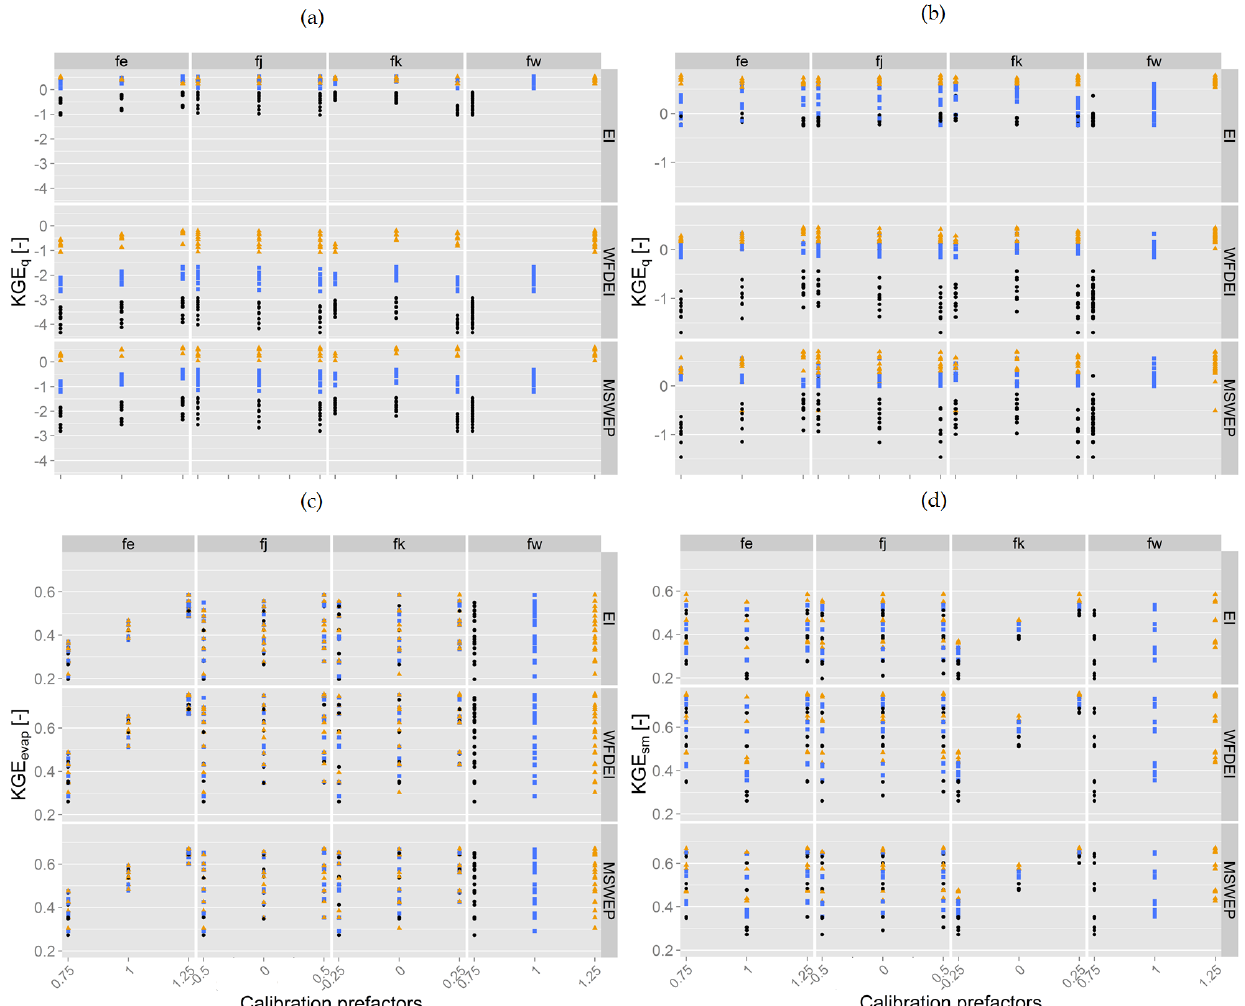
Figure 5. Scatter plots of discharge performance indicator KGE based on the monthly observations versus pre-factors f e , f j , f k and f w for the calibration scenarios S1 ( (a) Ait Ouchene (b) Mechra Eddahk), S2 (c) and S3 (d) . In each panel, columns indicate the different calibrated pre-factors and rows indicate the three global precipitation products used as model forcing. Different colours and dot shapes indicate different f w